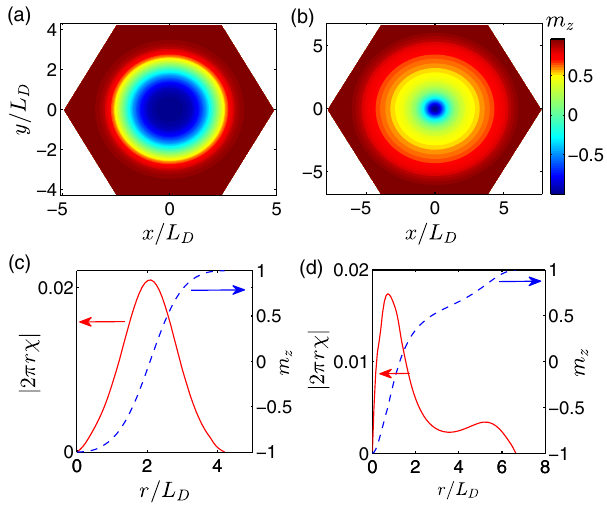
FIG. 2. Internal structure of skyrmions . Skyrmion core struc- ture from circular-cell calculation with D=J ¼ 0 . 01 and A J=D 2 ¼ 1 = 2 . Here, L ¼ ð J=D Þ a , where a is the microscopic c D lattice spacing. (a, b) False color plots of m z (shown in the color bar). (c, d) Angle-averaged topological charge density j 2 π r χ ð r Þj and m z ð r Þ (right axes). Panels (a) and (c) correspond to easy-axis anisotropy AJ=D 2 ¼ − 0 . 5 and HJ=D 2 ¼ 0 . 28 . The skyrmion core is conventional, with a single peak in the topological charge density. Panels (b) and (d) are for easy-plane anisotropy AJ=D 2 ¼ 1 . 35 and HJ=D 2 ¼ 1 . 96 . Here, the core has a large “ transition ” region (yellow-orange) from down (center) to up (boundary) in m , leading to an unusual two-peak structure for j 2 π r χ j